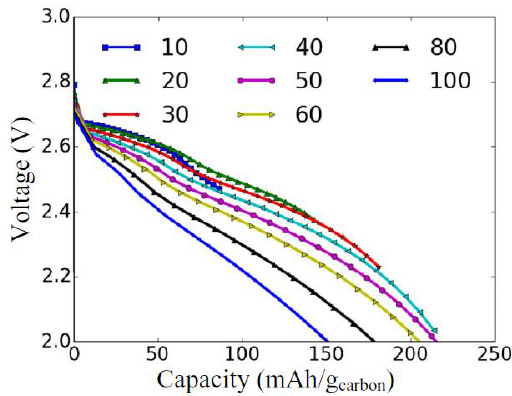
Figure 18. Discharge performance of lithium–oxygen batteries with various mean pore sizes (in nm). The critical pore size is 10 nm. Republished from Li [24] with permission of The Electrochemical Society conveyed through Copyright Clearance Center, Inc.